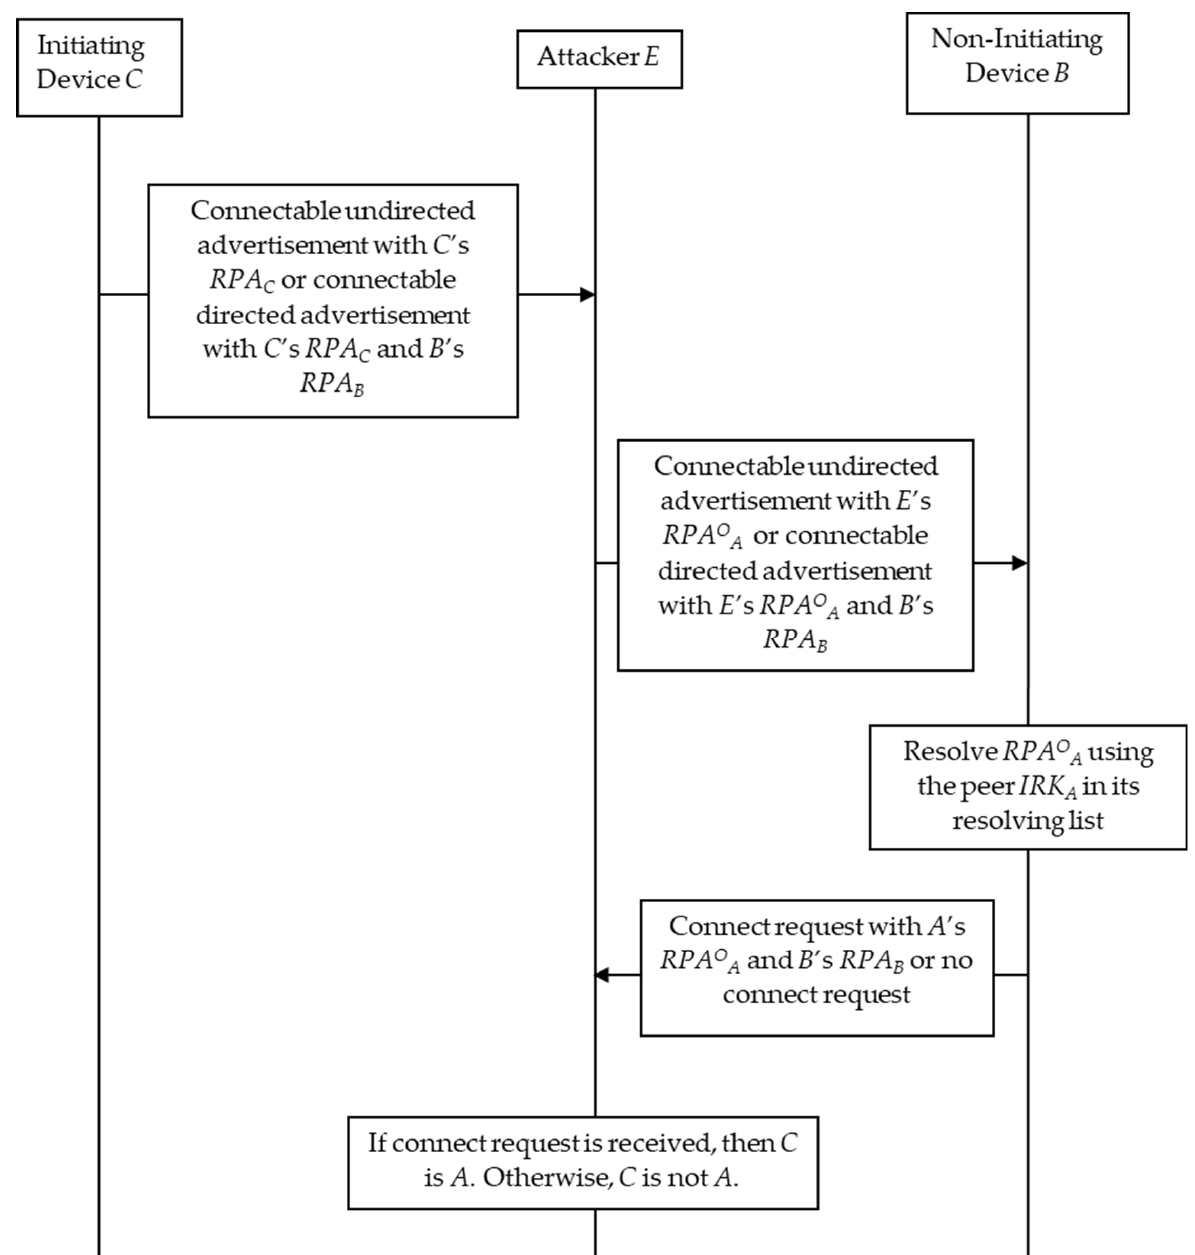
Figure 8. Tracking A using the reconnection procedure.